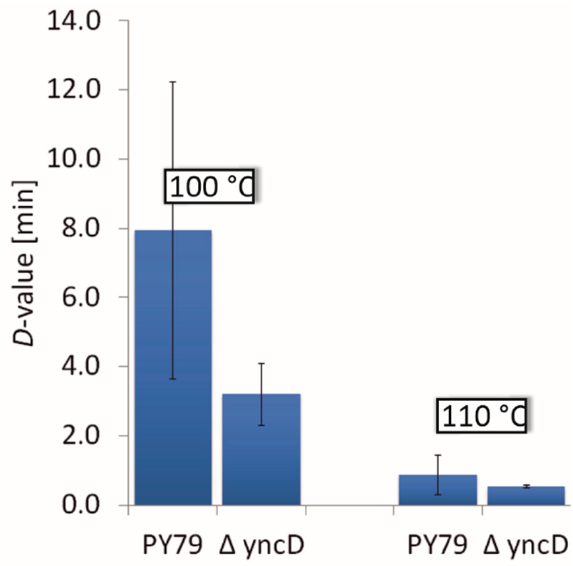
Figure 3. Heat resistance of wild-type and Δ yncD spores. The average D-values calculated for 100 °C and 110 °C are shown. Table 2. Heat resistance of the wild-type and Δ yncD spores. D -values were calculated using a log- linear model for three independent spore preparations at 100 °C and 110 °C. R 2 is a regression sta- tistic which reflects how well the regression predictions agree with the real data. The closer this value is to the value 1, the closer the measured points are to the calculated ones.